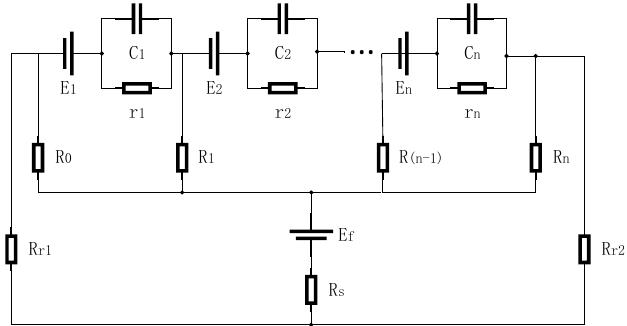
Figure 2. Insulation detection model between the battery and chassis of an electric vehicle.